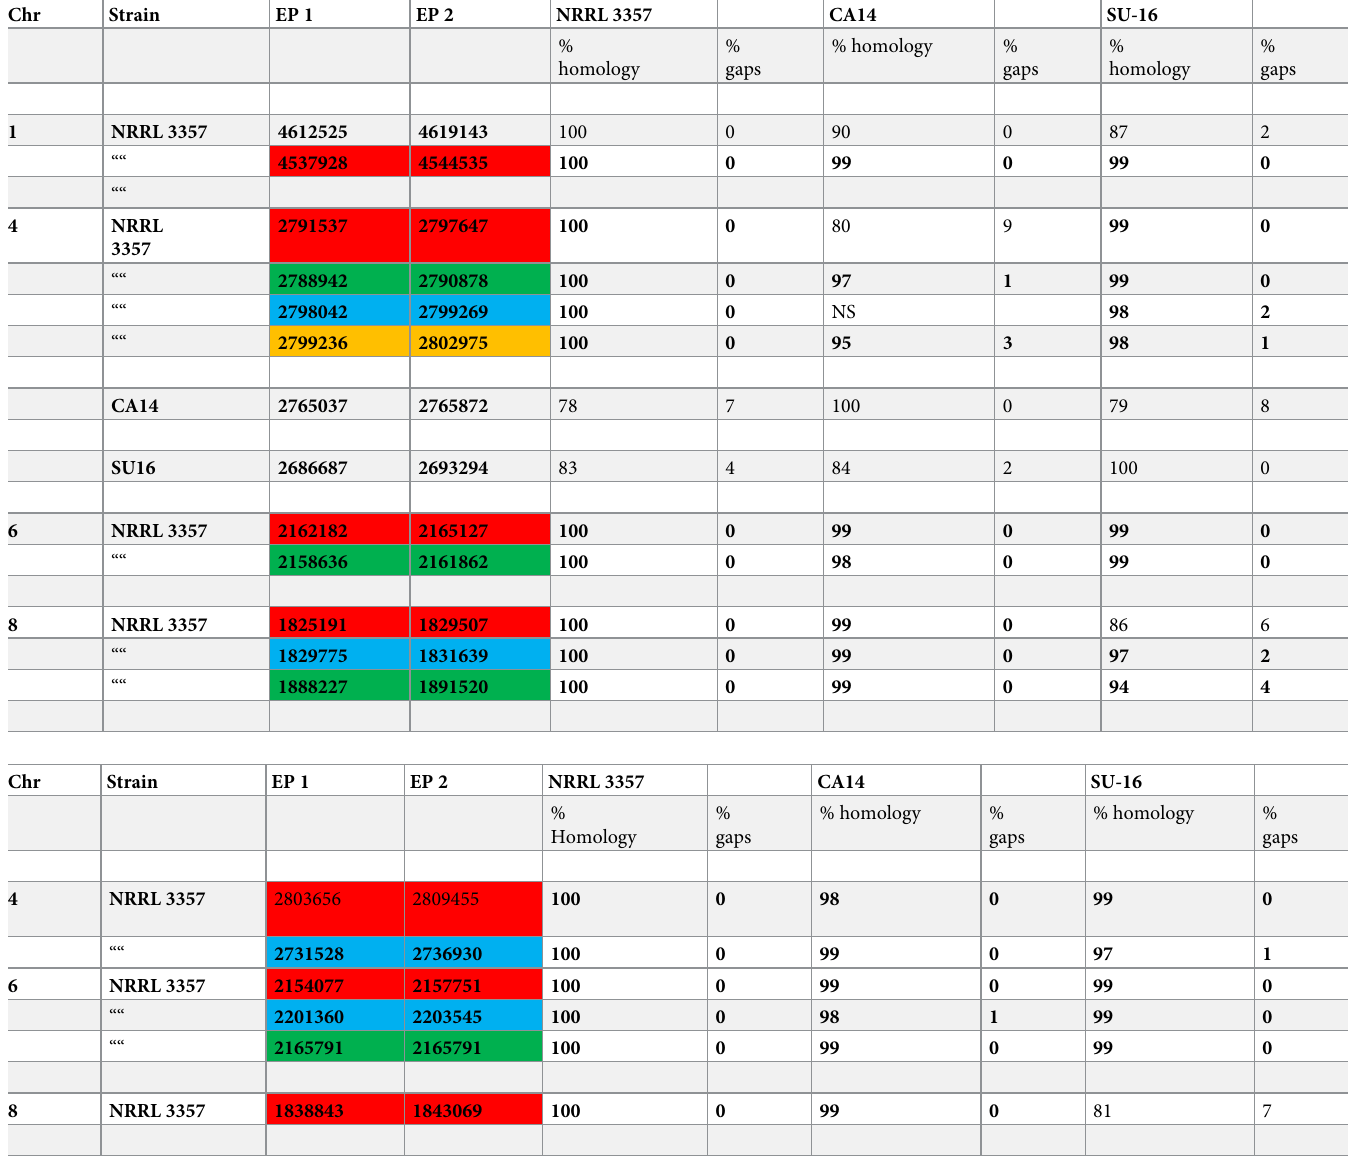
Table 6. Homology of Gypsy 4 elements at clustered and non-clustered sites in chromosomes 1, 4, 6, and 8. A. B. Homology of Gypsy 2 elements at clustered and non-clustered sites in chromosomes 4, 6, and